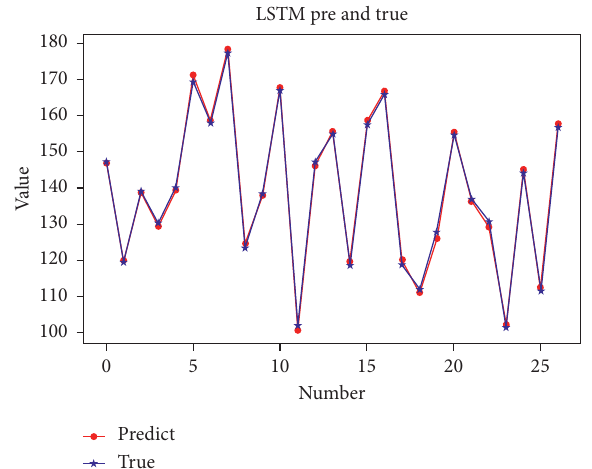
Figure 5: Prediction fitting of the LSTM model.